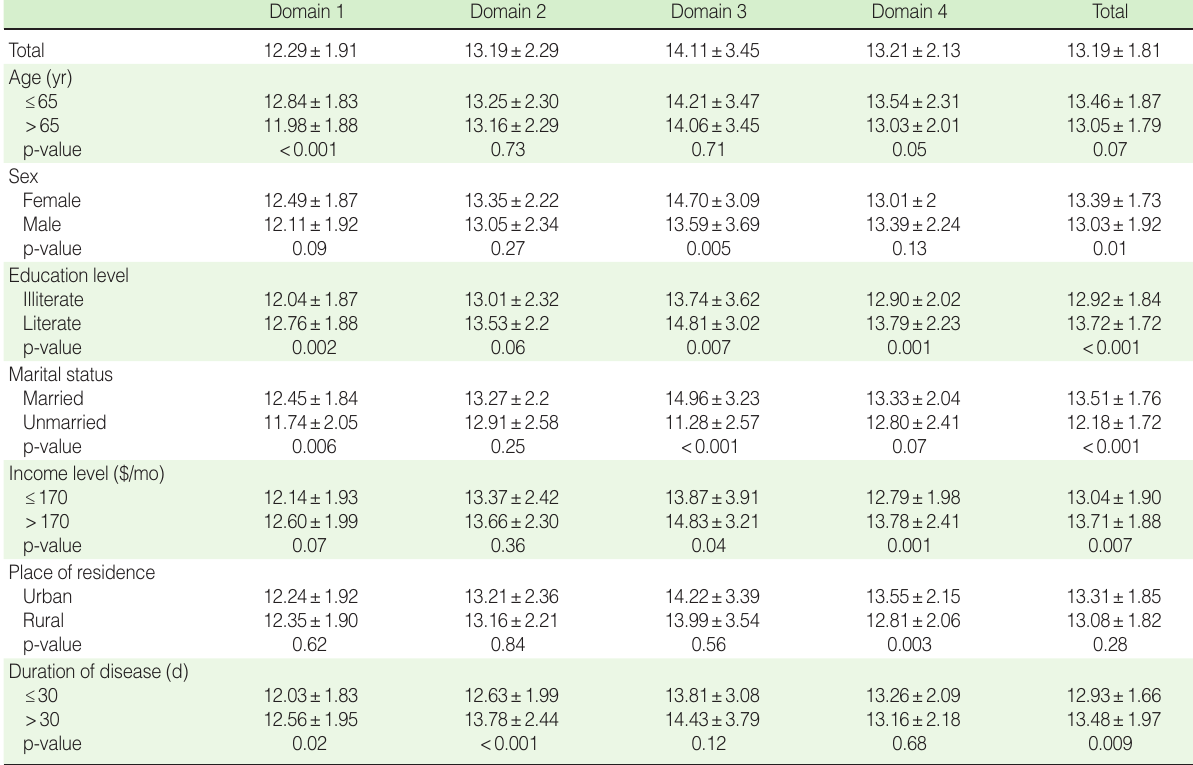
Table 5. Comparison of the scores in the four domains of the World Health Organization Quality of Life Instrument, Short Form according to independent